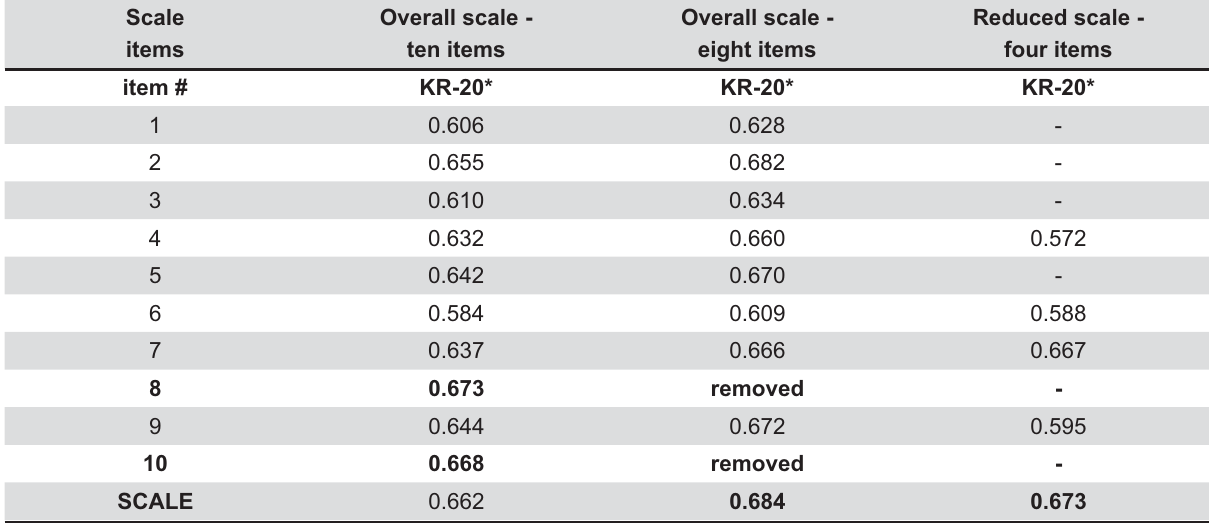
Table 2- Internal consistency results for the overall scale and for the selected items according to the multivariate analysis